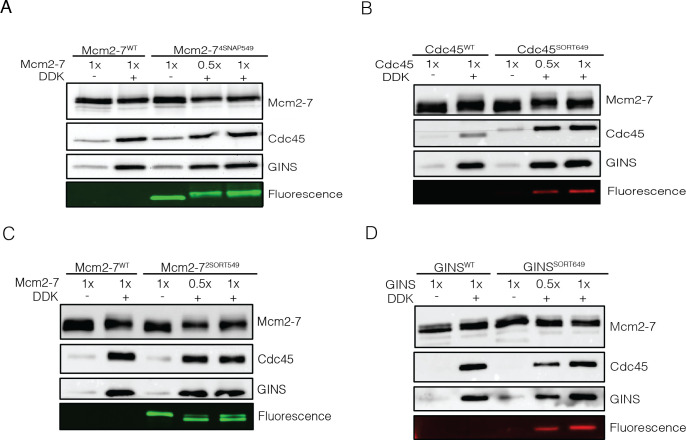
Fluorescently labeled proteins function at wild-type levels in ensemble Cdc45-Mcm2-7-GINS (CMG)-formation assays.Mcm2-7 was loaded onto bead-coupled 3.8 kb plasmids and subsequently phosphorylated with Dbf4-dependent kinase (DDK). The phosphorylation reaction mix was removed without washing the beads prior to addition of helicase-activation proteins. Beads were washed with high-salt buffer, and Mcm2-7 proteins, Cdc45, and GINS were detected by immunoblot. Omission of DDK was used as a control for non-specific DNA binding of Cdc45 and GINS. (A) Mcm2-74SNAP549 does not interfere with Mcm2-7 loading or Cdc45/GINS recruitment. (B) Cdc45SORT649 does not interfere with Cdc45 or GINS recruitment to CMG. (C) Mcm2-72SORT549 does not interfere with Mcm2-7 loading or Cdc45/GINS recruitment. (D) GINSSORT649 does not hinder Cdc45 or GINS recruitment to CMG.